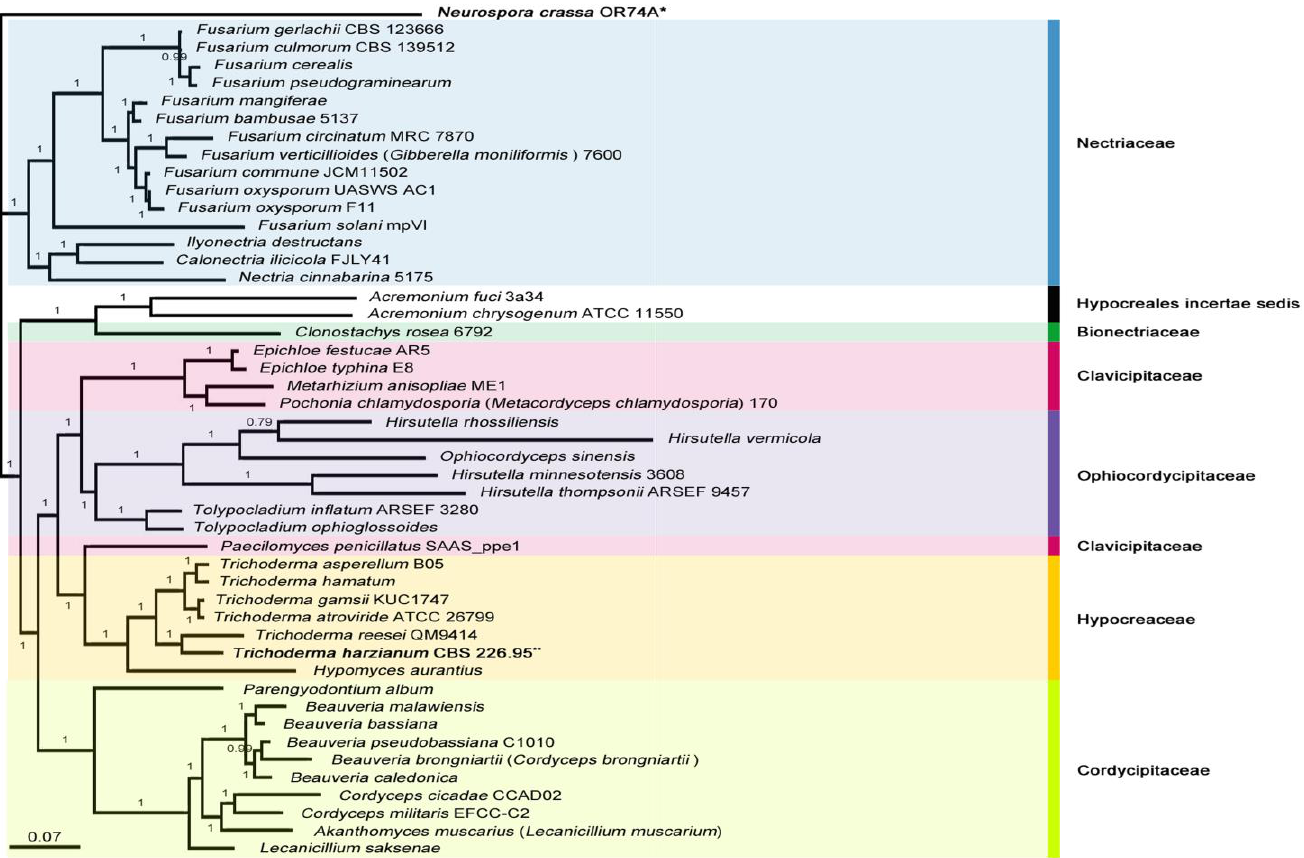
Figure 2. Bayesian phylogeny for a position of the T. harzianum CBS 226.95 mitogenome in Hypocreales. The tree was generated using concatenated sequences of 13 core genes ( atp6, atp8, cob, cox1 , cox2 , cox3 , nad1 , nad2 , nad3 , nad4 , nad4L , nad5 , and nad6 ), and the mitochondrial genome of Neurospora crassa OR74A (Sordariales) was used as an outgroup. All Sordariomycetes species that used for the phylogenetic tree are described in Table S5, and Bayesian posterior probabilities (BPPs) values were marked on the nodes. Asterisks for the Neurospora crassa OR74A mitogenome (*) and T. harzianum CBS 226.95 mitogenome (**).